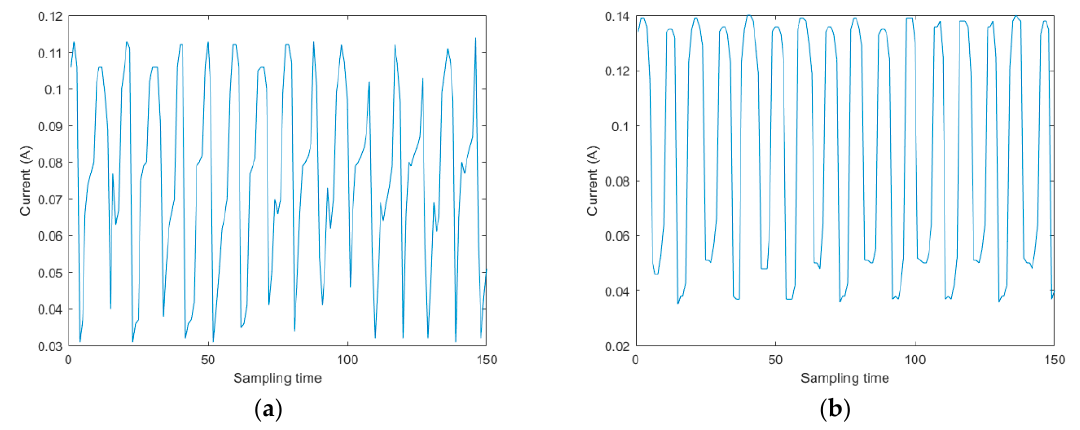
Figure 16. Current consumption: ( a ) with magnetic force, ( b ) without magnetic force.